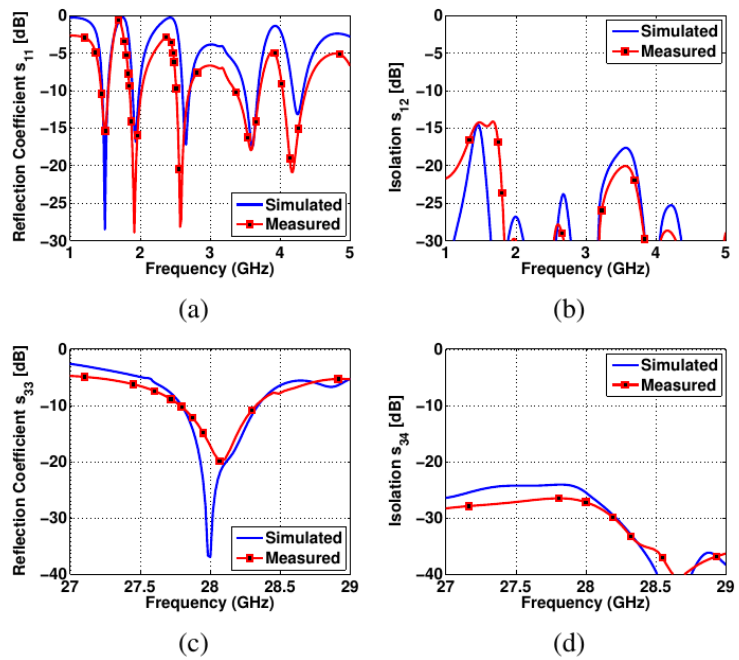
Figure 10. Curves showing measured and simulated values: ( a ) S 11 , ( b ) S 12 , ( c ) S 33 , ( d ) S 34 . Similarly, the activation of Feeds 3 and 4 causes the antenna to function in the millimeter-wave band. The reflection coefficient when these feeds are excited is shown in Figure 10c. As a result, the antenna operates between 27.8 and 28.3 GHz, covering the 28 GHz 5G band. As shown in Figure 10d, the isolation between the antenna elements in this band is greater than 25 dB. To analyze the mutual coupling between antenna elements for sub-6GHz operation, the current density distribution was analyzed at 4.25, 3.6, 2.69, and 1.98 GHz, as shown in Figure 11a–d, respectively. Low mutual coupling values were observed for the given frequency bands. Such analyses are important when it comes to designing a defected ground structure to enhance the isolation between closely spaced antenna elements. The electrical distance between antenna elements is smaller at sub-6GHz when compared to the millimeter-wave band. Hence, low isolation levels were obtained at